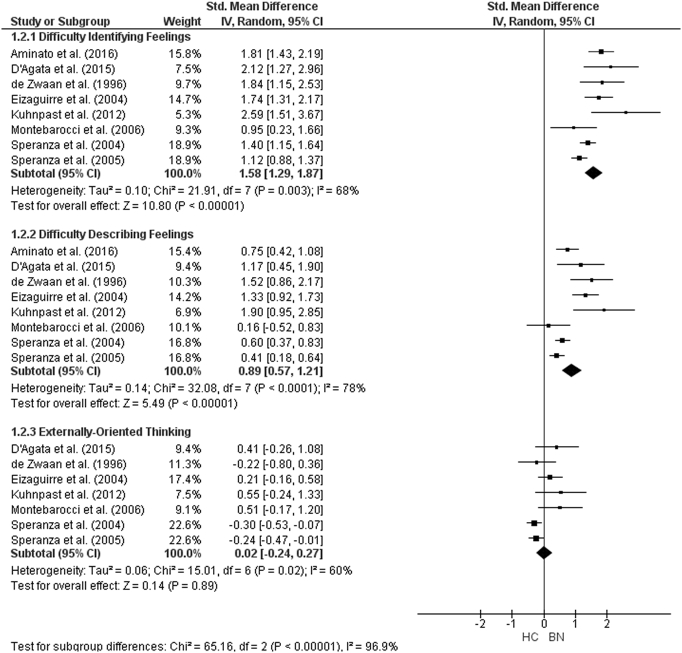
Forest plot of mean TAS subscale scores: standardized mean effect size for differences (SMD) between Bulimia Nervosa (BN) and Healthy Controls (HC). CI, confidence interval.